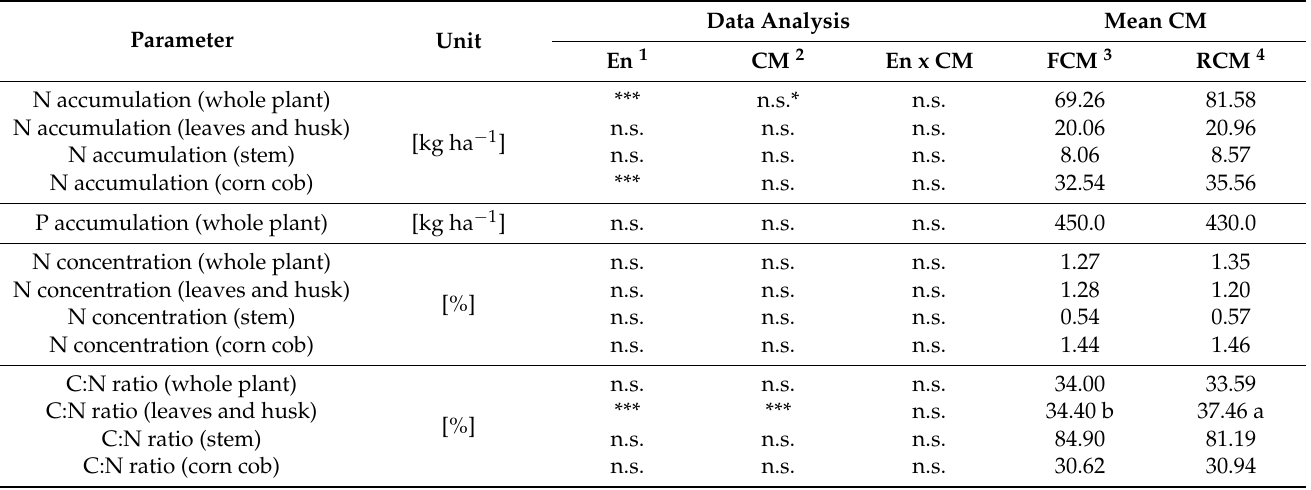
Table 5. Results of a multiple comparison statistical analysis of maize crop yield. Environment, x Culti- vation method, n.s.—not significant, n.s.*—not significant, but tends to be significant, ***—significance. Arithmetic means of all Environments. Eight replications in Environment Oberhermsgrün 2018 (OG18). Four replications in Environemnt Bergen 2020 (BR20). Different letters indicate significance at p < 0.05.